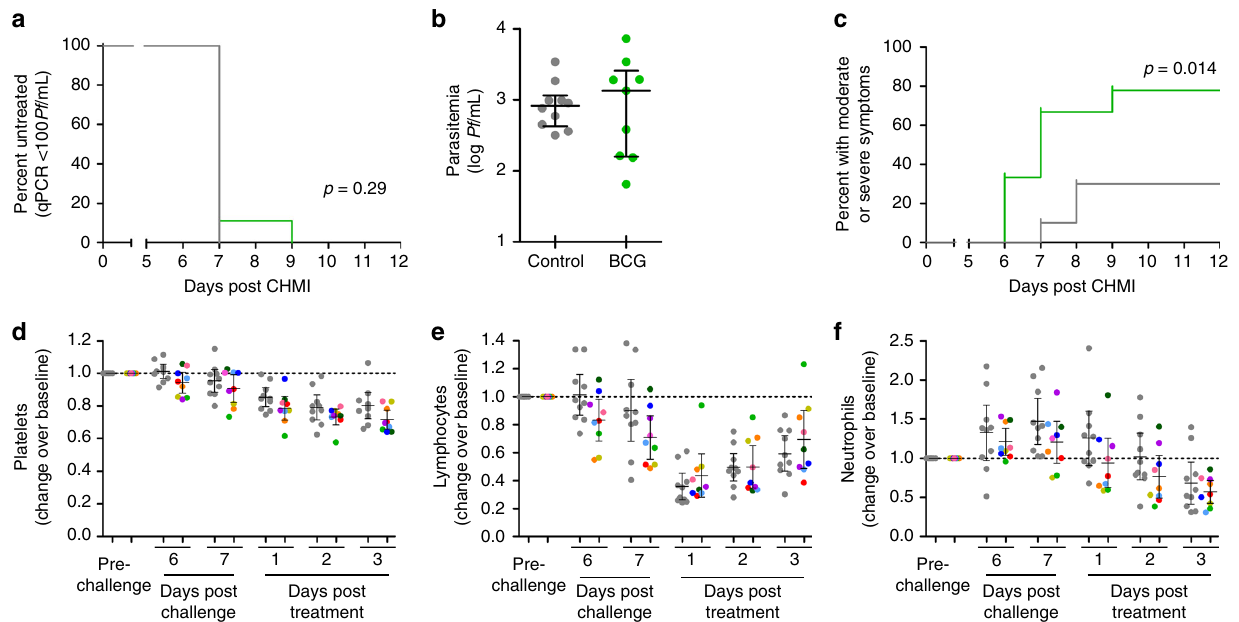
Fig. 1 Parasitemia, clinical symptoms and laboratory abnormalities after CHMI. Parasitemia was measured by daily qPCR from day 6 after CHMI until the third day after antimalarial treatment. a The Kaplan – Meier survival curve shows percent of volunteers remaining untreated. 8/9 BCG vaccinated (green) and 10/10 control volunteers (grey) surpassed the treatment threshold of 100 parasites per millilitre, and were treated on day 7 after challenge. 1/9 BCG vaccinated volunteers remained below 100 Pf/mL until day 9. b All volunteers did have parasitemia detectable by qPCR on day 7 after CHMI. The graph shows log parasites per millilitre on day 7 post CHMI for BCG vaccinated (green) and control (grey) volunteers. c Adverse events were collected daily. The Kaplan – Meier curve shows the percentage of volunteers experiencing one or more moderate or severe, solicited, symptoms during follow-up, BCG vaccinated volunteers (green) compared to controls (grey). d – f Absolute platelet, lymphocyte and neutrophil differentiation counts were determined by daily hemocytometry starting on day 6 post-challenge. Graphs show relative change in cell counts compared to pre-challenge values in both BCG vaccinated ( n = 9, each coloured dot shows and individual volunteer, colours consistently represent the same volunteers across each graph) and non-BCG vaccinated controls ( n = 10, grey